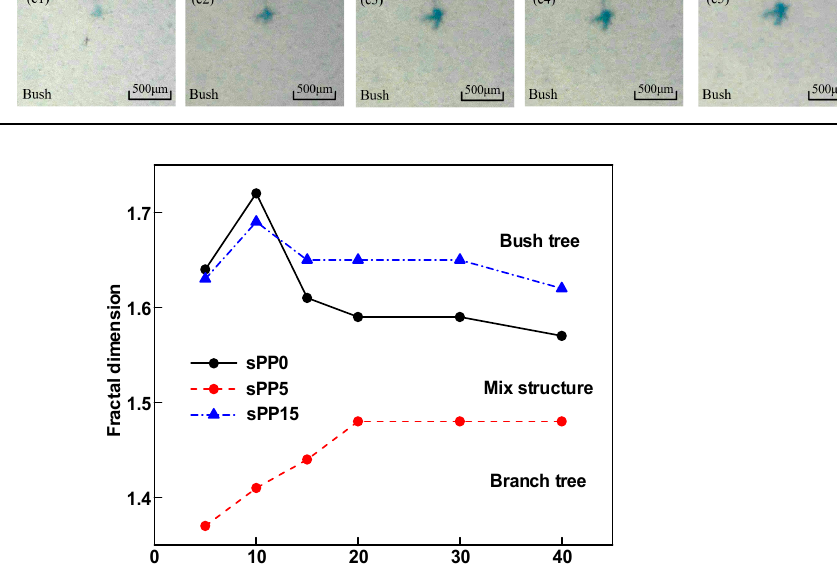
Figure 6. Time-varying fractal dimension of sPP0, sPP5, and sPP15 at 70 °C under AC voltage of 6 kV.